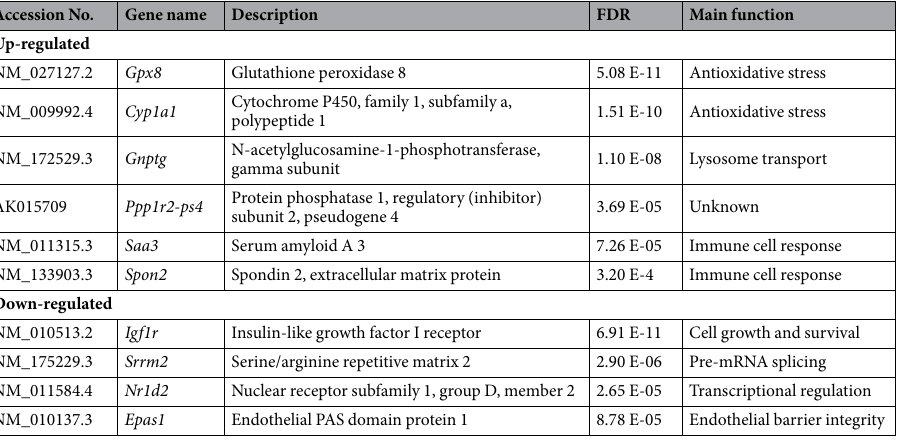
Table 1. Top 10 differentially expressed genes in the lung of UBC-CreERT2 ; Igf1r fl / fl mutant mice, and their assigned main